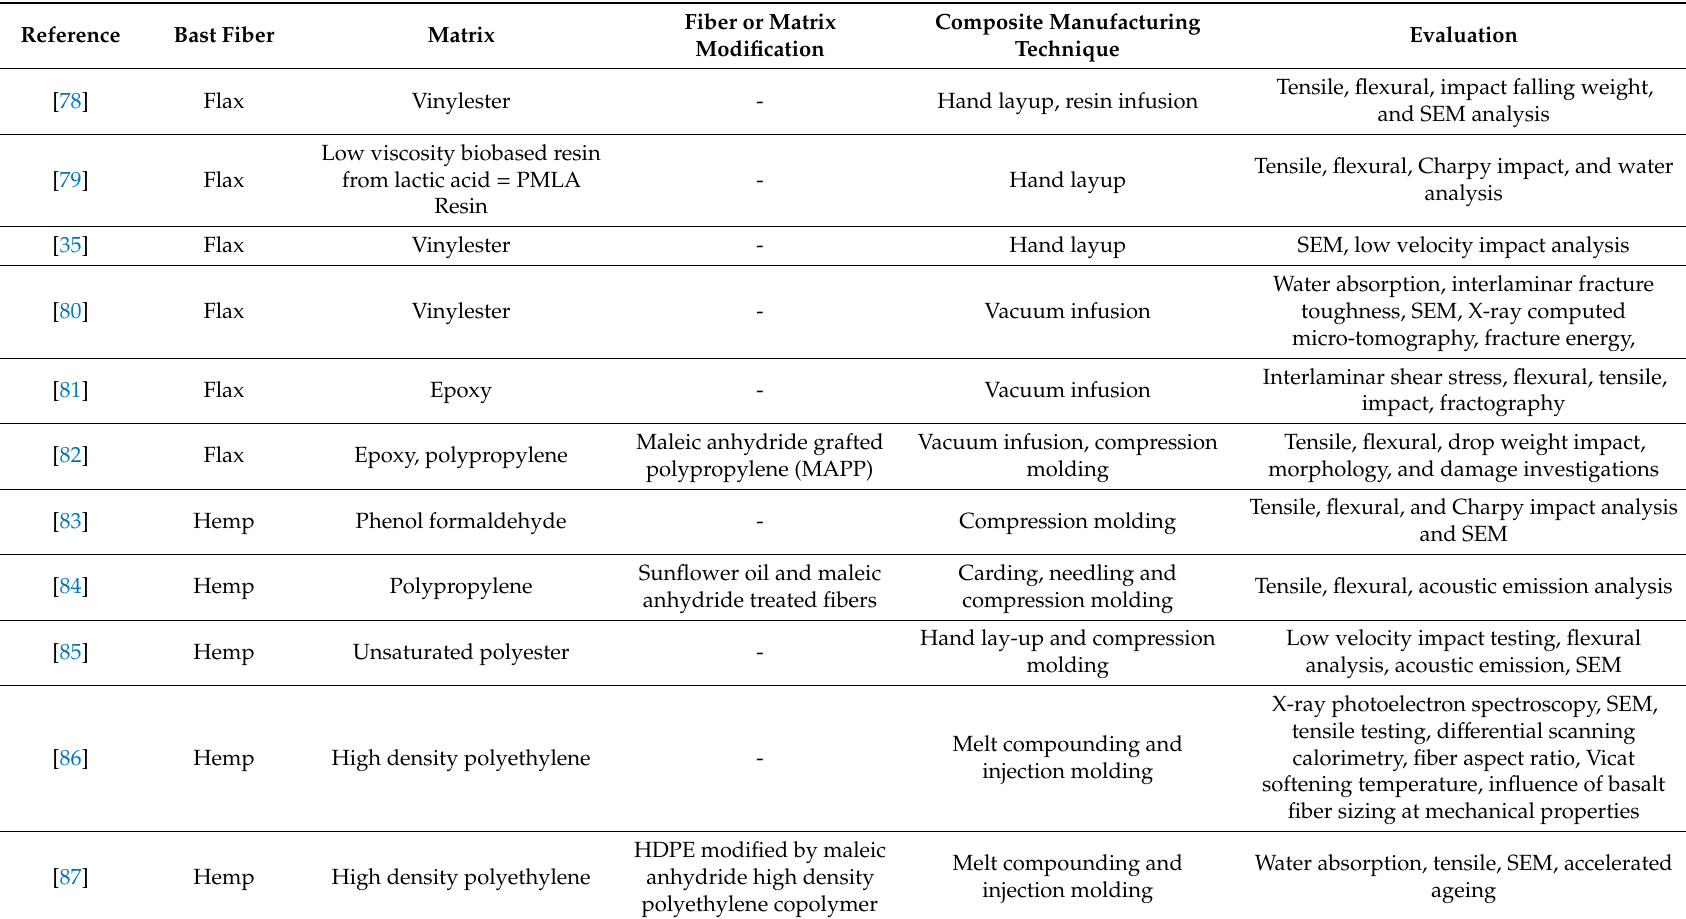
Table 6. Research contributions about hybrid bast / basalt